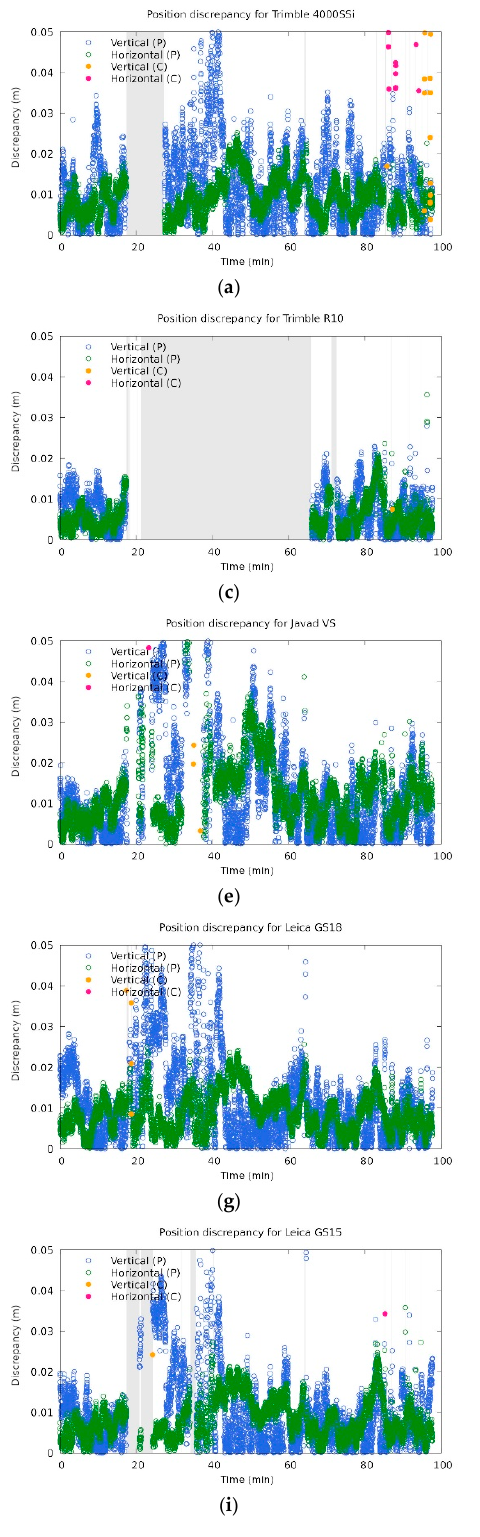
Figure 10. Position discrepancies for the involved instruments: ( a ) Trimble 4000 SSi, ( b ) Trimble R8, ( c ) Trimble R10, ( d ) Trimble R8s, ( e ) Javad Triumph-VS, ( f ) Javad Triumph-LSA, ( g ) Leica GS18, ( h ) Leica GS07, and ( i ) Leica GS15 in the region up to 5 cm. Annotations P and C mean phase fix and code solution respectively. The grey regions are the intervals where the instruments did not report any position. The time origin was set to 08:20 UTC time. Code solutions mostly fall outside of the plotting region and are thus not shown.